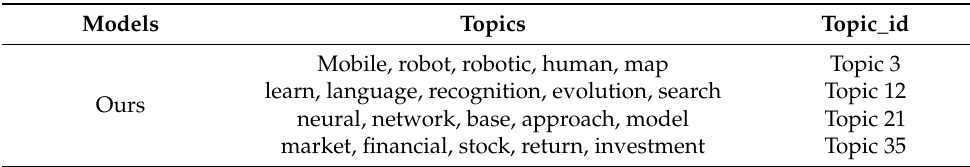
Table 7. Some examples of the model in this paper at K = 50 topics.